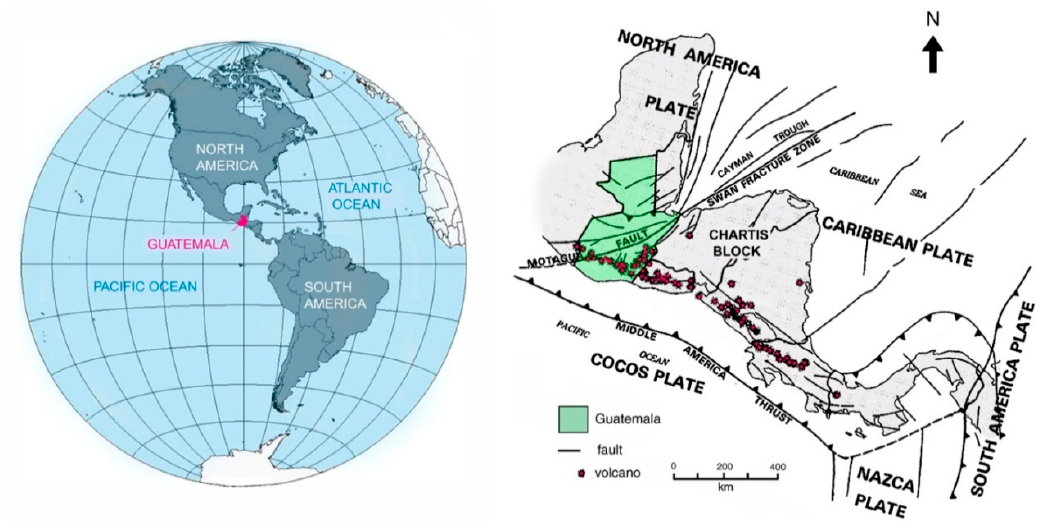
Figure 5. Generalized tectonic architecture of Central America. Modified from [6].